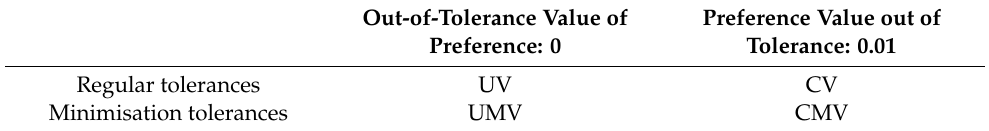
Table 6. Optimization variants.